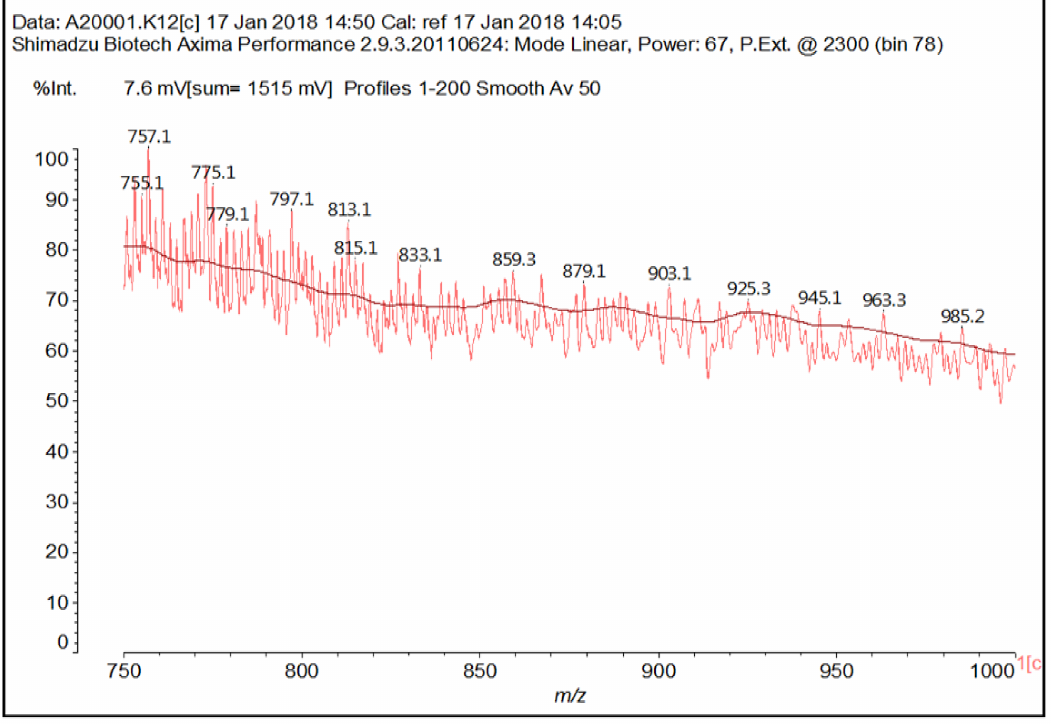
Figure 11. MALDI ToF spectrum of the A2 NIPU resin. Detail of the 750–1000 Da